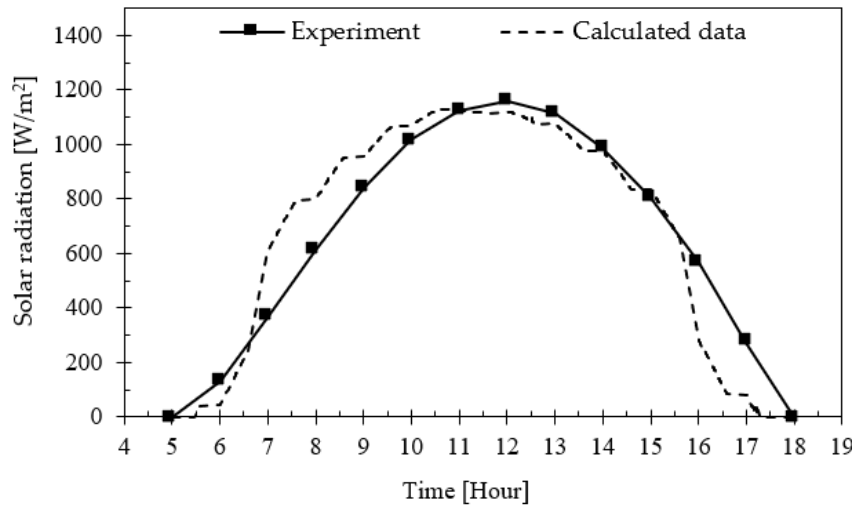
Figure 9. Solar radiation measured on the PV panel compared to the data obtained via calculation [47].